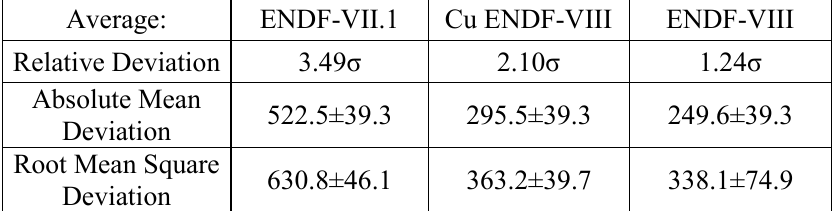
Table IV. Average Deviations from Experimental Criticality: Comparison of ENDF-VII.1 and VIII.